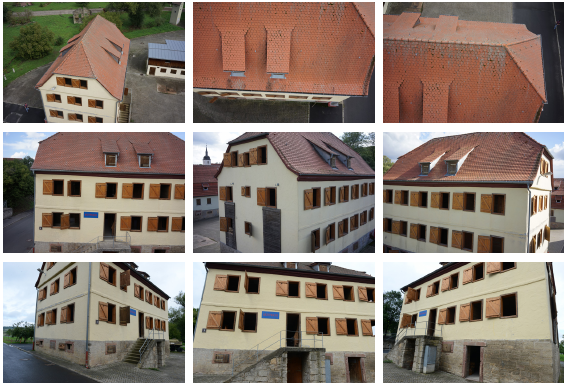
Figure 1. Input images from an aerial (UAV – top and center) and a terrestrial (bottom)